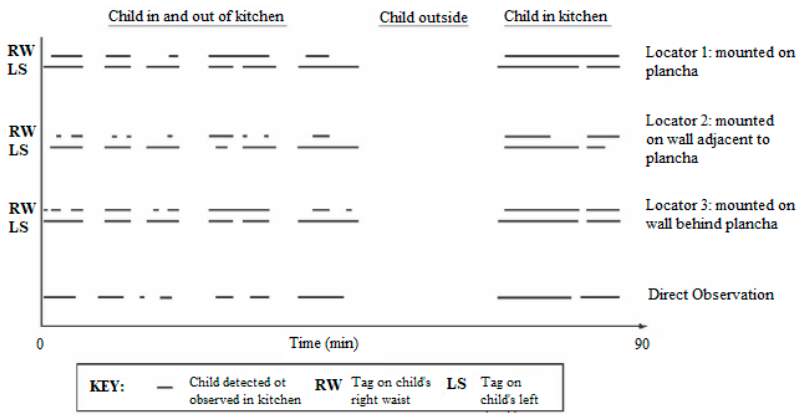
Figure 6. Direct observation vs. UCB-TAMS data for one mealtime observation. The lowest set of dashes represent time that the child was in the kitchen based on fieldworker observation—the ‘gold standard’. Adapted from Piccolo-Allen [33].